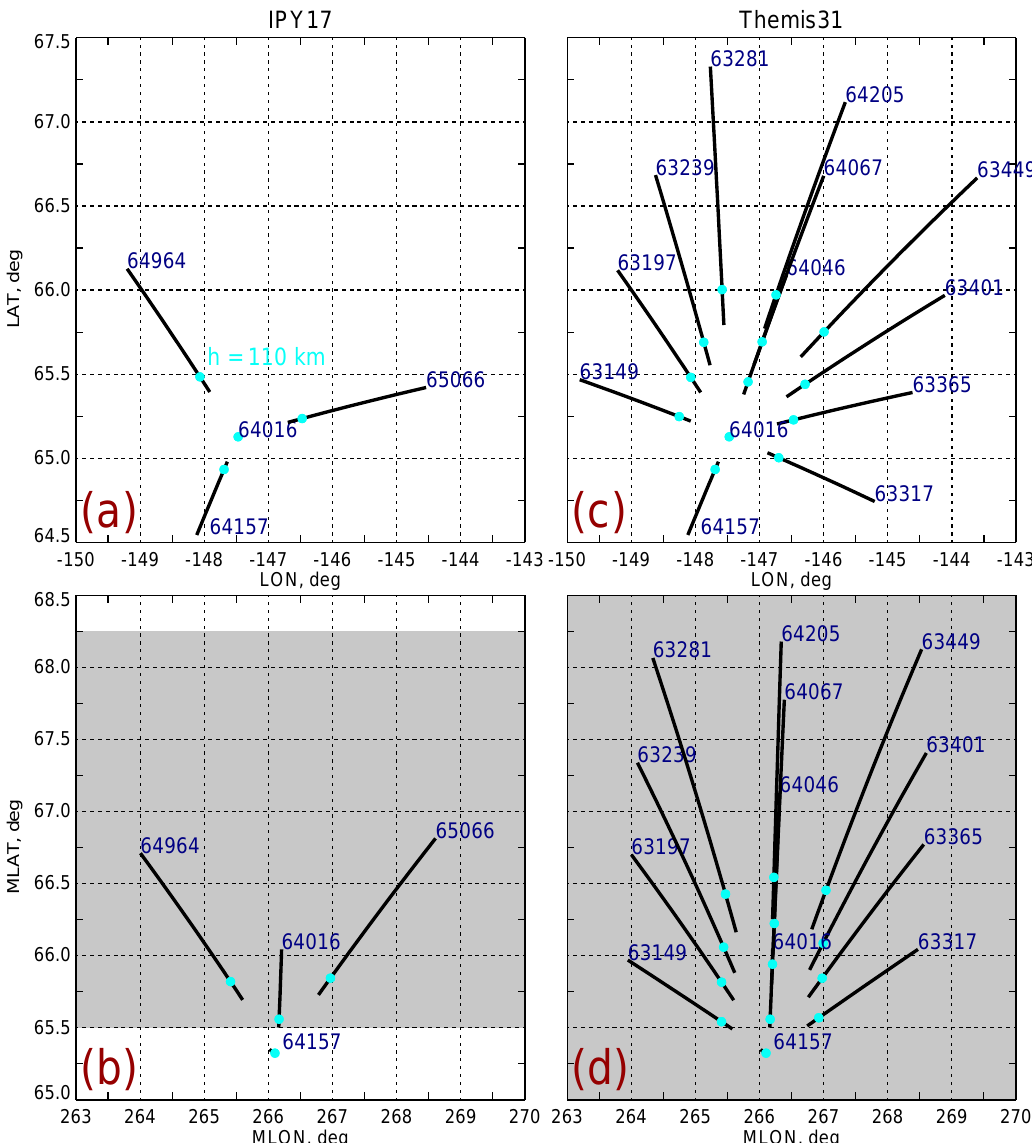
Fig. 1. PFISR experiment configuration for (a) and (b) IPY17 and (c) and (d) Themis31 modes. Shown are the PFISR beams in (a) and (c) geographic and (b) and (d) geomagnetic coordinates corresponding to the alternative coding (AC) data. The start of the gate nearest to a 110-km altitude is shown by a circle for each beam. The standard PFISR beam identification is also given by the digits near the maximum altitude coordinates. The grey-shaded area in (b) and (d) shows magnetic latitudes with convection ion velocity and electric field vectors from the long pulse (LP)